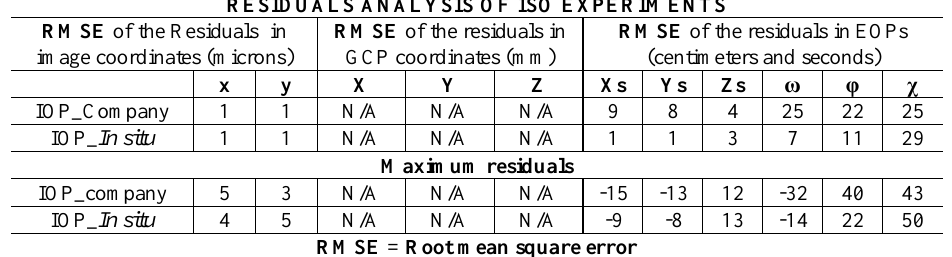
Table 3. Main results of the residuals analysis of the ISO experiment of the first block without control points